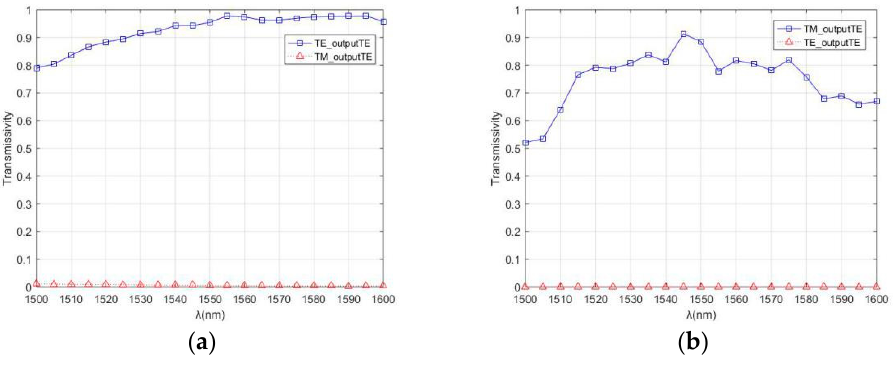
Figure 9. When n is 5, the transmission spectrum of ( a ) TE polarized light and ( b ) TM polarized light at the output end.